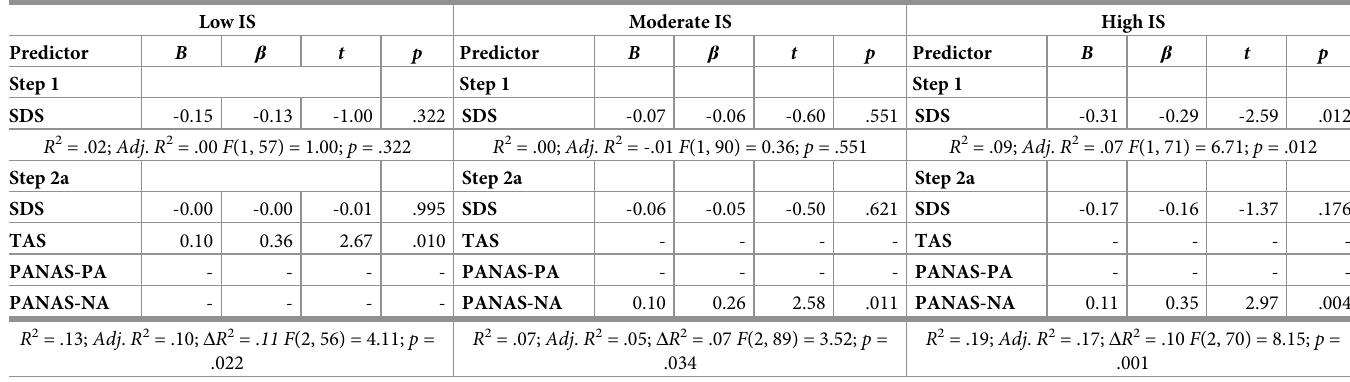
Table 4. Regression coefficients among three IS clusters. Low IS Moderate IS High IS Predictor